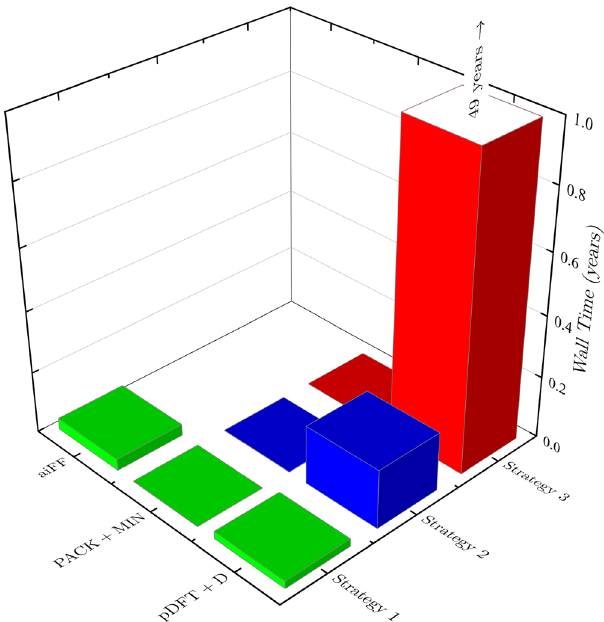
Fig. 3 Computational cost of the considered CSP protocols. Total wall times required for system I CSPs on a single core of the Intel E5-2670 processor using different strategies. Rows “ aiFF ” , “ PACK + MIN ” , and “ pDFT + D ” denote times of an aiFF development, packing and minimization, and of periodic DFT + D